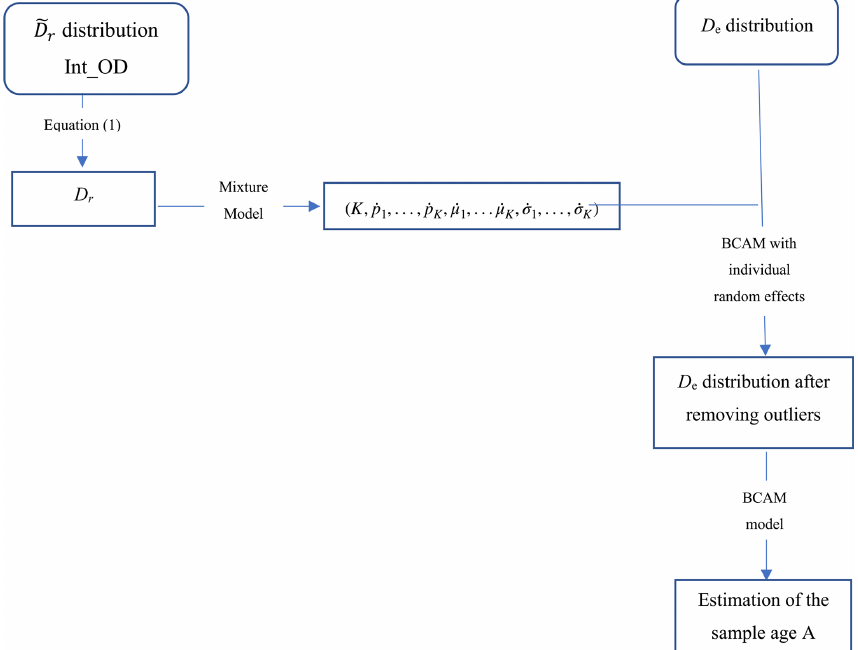
Figure 2. Diagram representing the different steps of the estimation method.